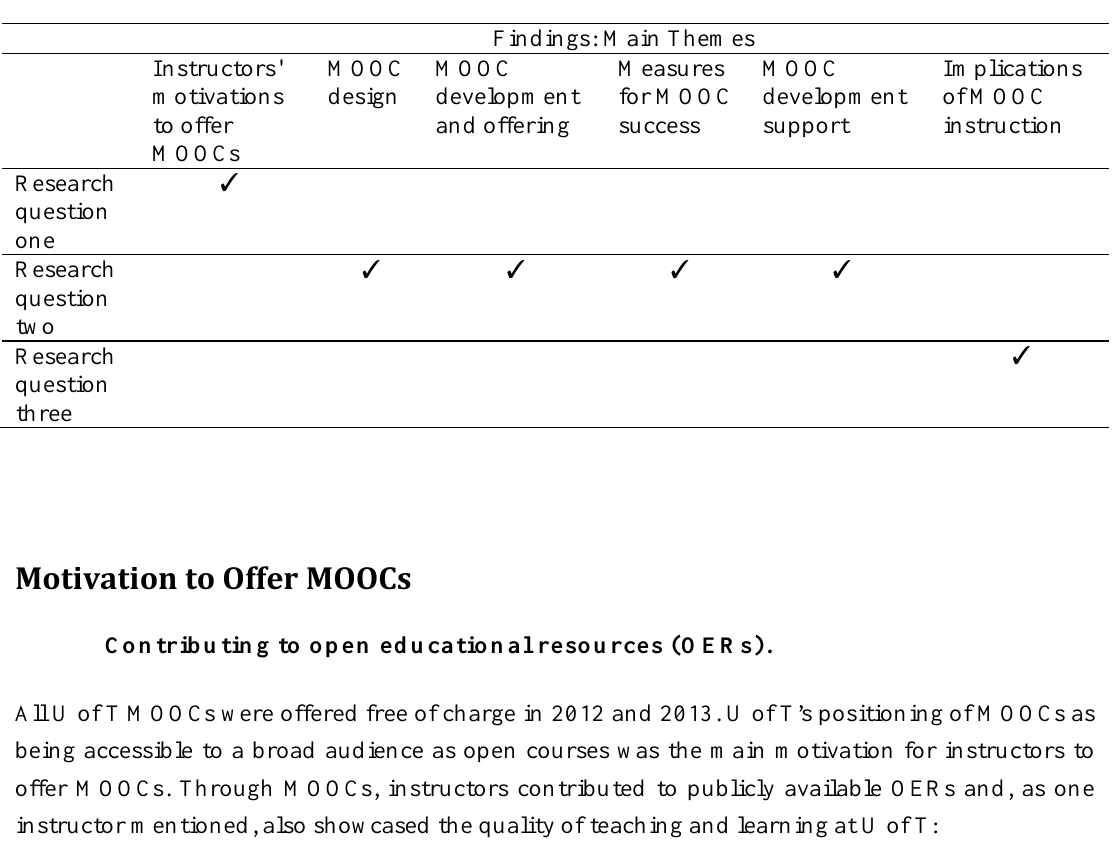
Table 1 Findings: Mapping of the Six Themes to Three Research Questions